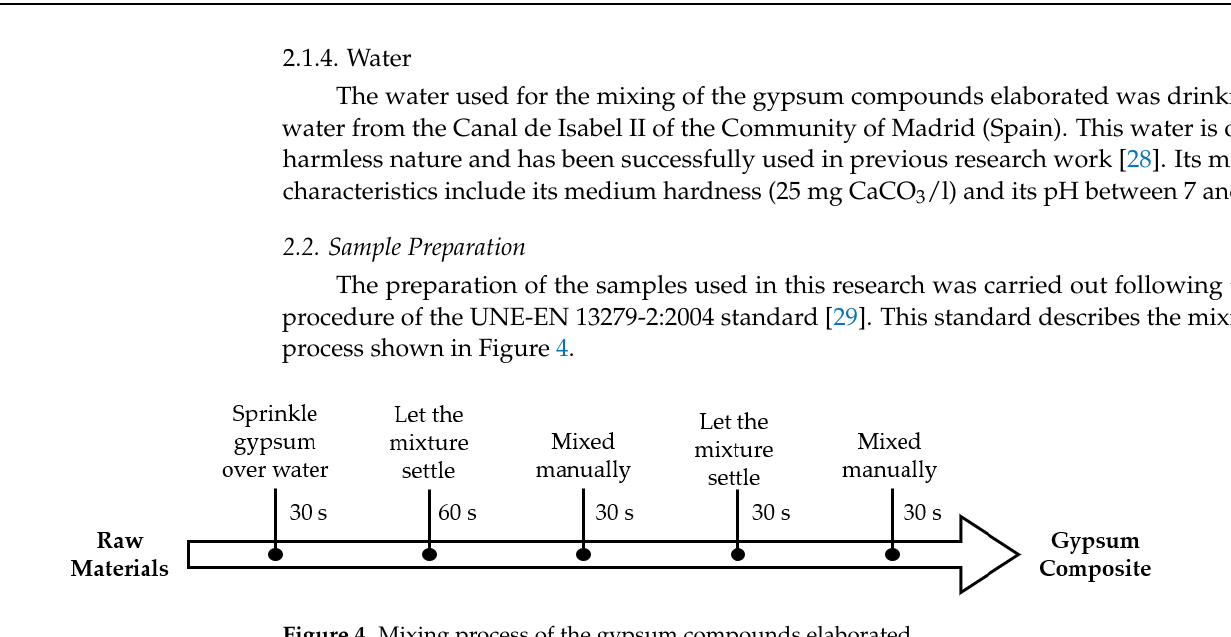
Figure 4. Mixing process of the gypsum compounds elaborated.